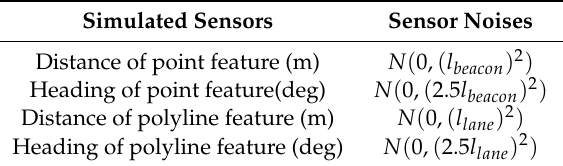
Figure 5. Concept of perception simulators for beacons and lanes. Table 1. Sensor noise